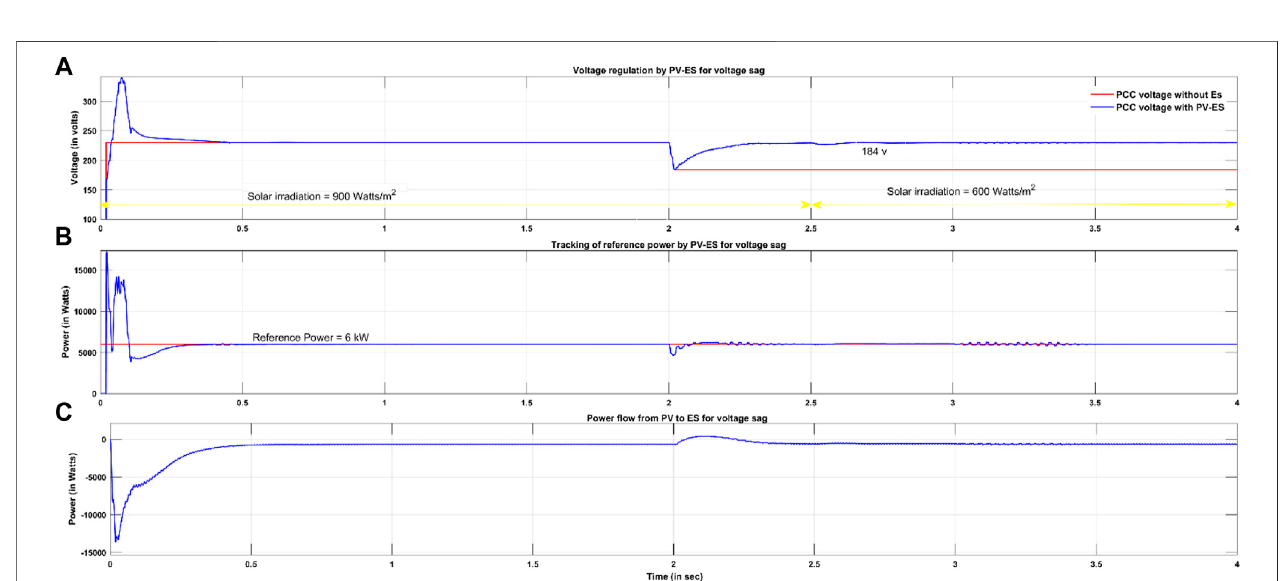
FIGURE 6 | PV-ES for voltage